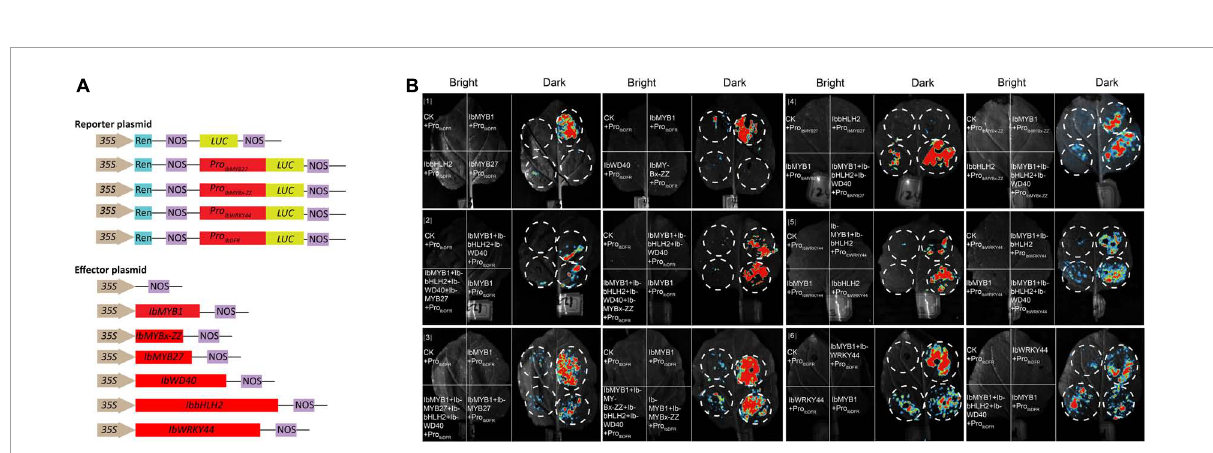
FIGURE7 Identification of IbMYB1, IbMYB27, IbMYBx-ZZ, IbWRKY44, IbWD40, and IbbHLH2 transactivation activities of IbDFR, IbMYB27, IbMYBx-ZZ, and IbWRKY44 promoters by a dual-luciferase assay. (A) Schematic of reporter and effector constructs used in transient expression assay. (B) Transient expression assays showing that different TFs activates or represses the transcriptional function of promoters. Luminescence images of Nicotiana benthamiana leaves are shown 48 h after coinfiltration with the constructs indicated in the left. The red color represents strong signal, whereas the blue color represents weak